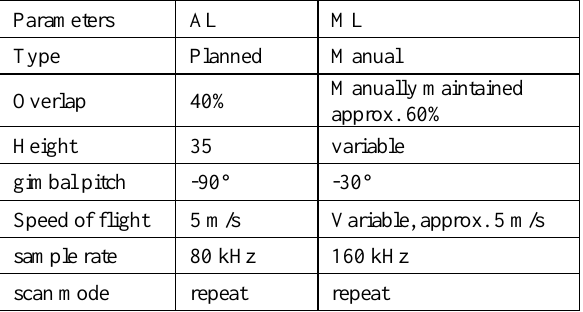
Table 1. The flights' characteristics